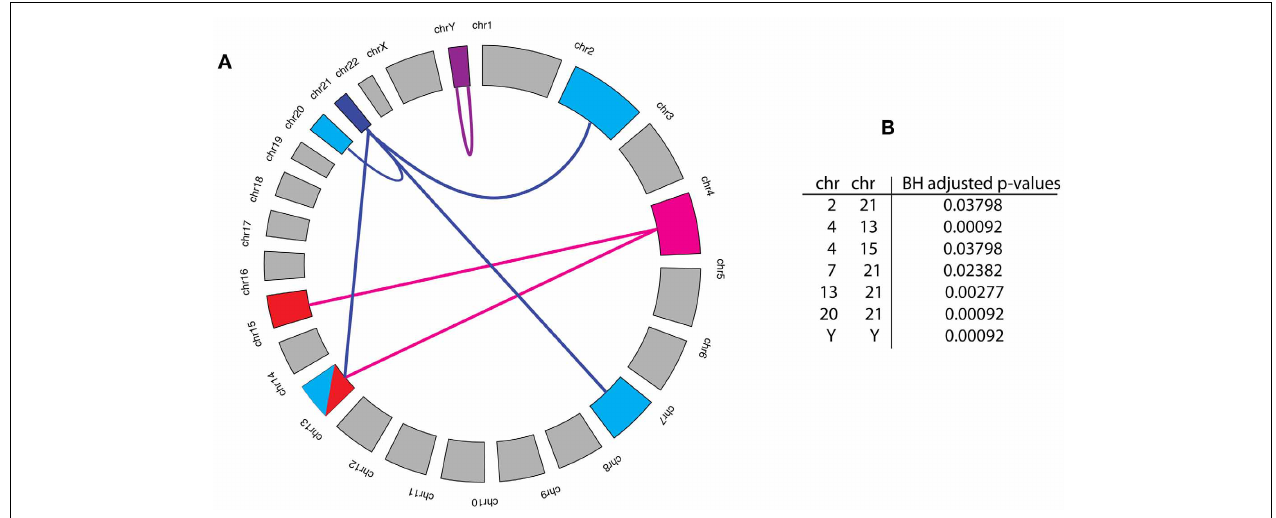
FIGURE 3 | (A) Statistically significant cooperations between chromosome pairs are highlighted by a link. The Benjamini and Hochberg (BH) adjusted p -values for these links are shown in the